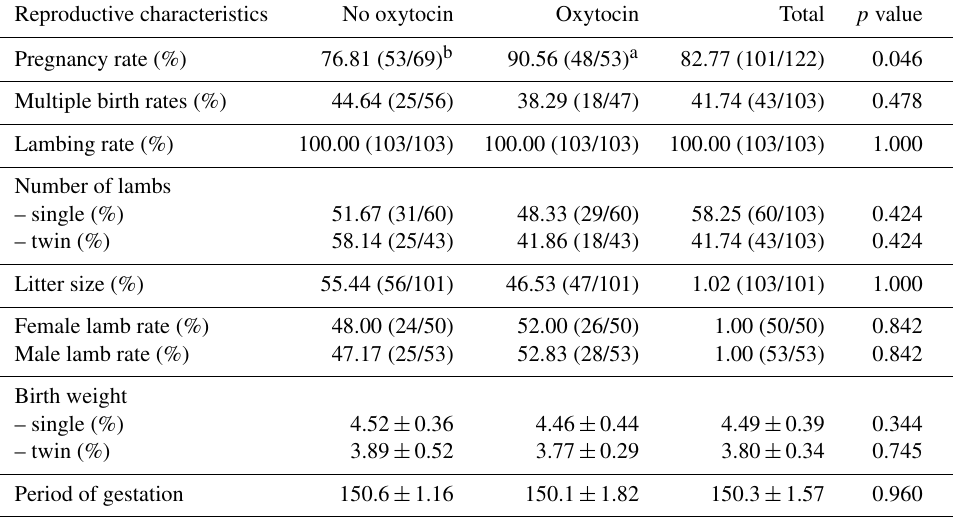
Table 2. Reproductive performance values of sperm fluids containing oxytocin and no oxytocin. Reproductive characteristics